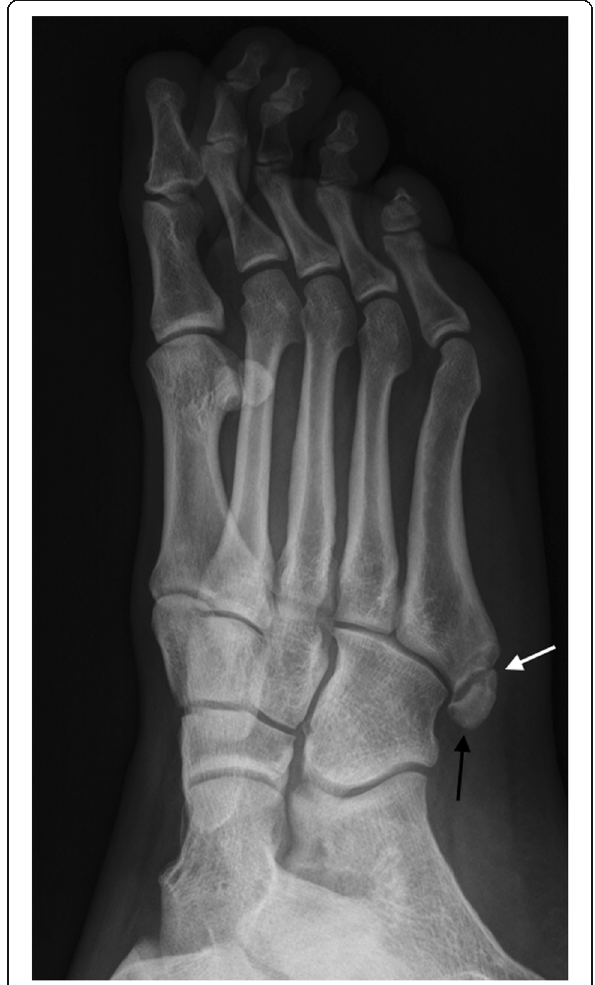
Fig. 17 Differential of os vesalianum. Oblique radiograph. Old non- united fracture fragment of the apophysis of the fifth metatarsal (black arrow). The fracture line is visible (white arrow). This finding, in some occasions, can resemble an os